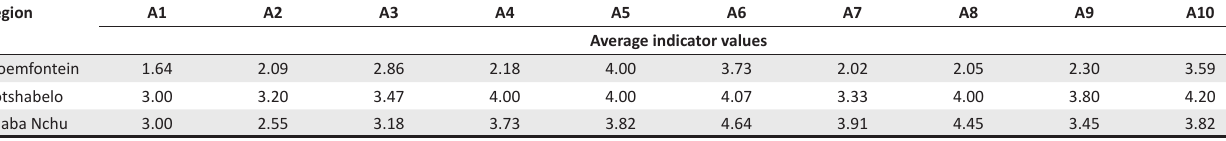
TABLE 4: Average indicator values.